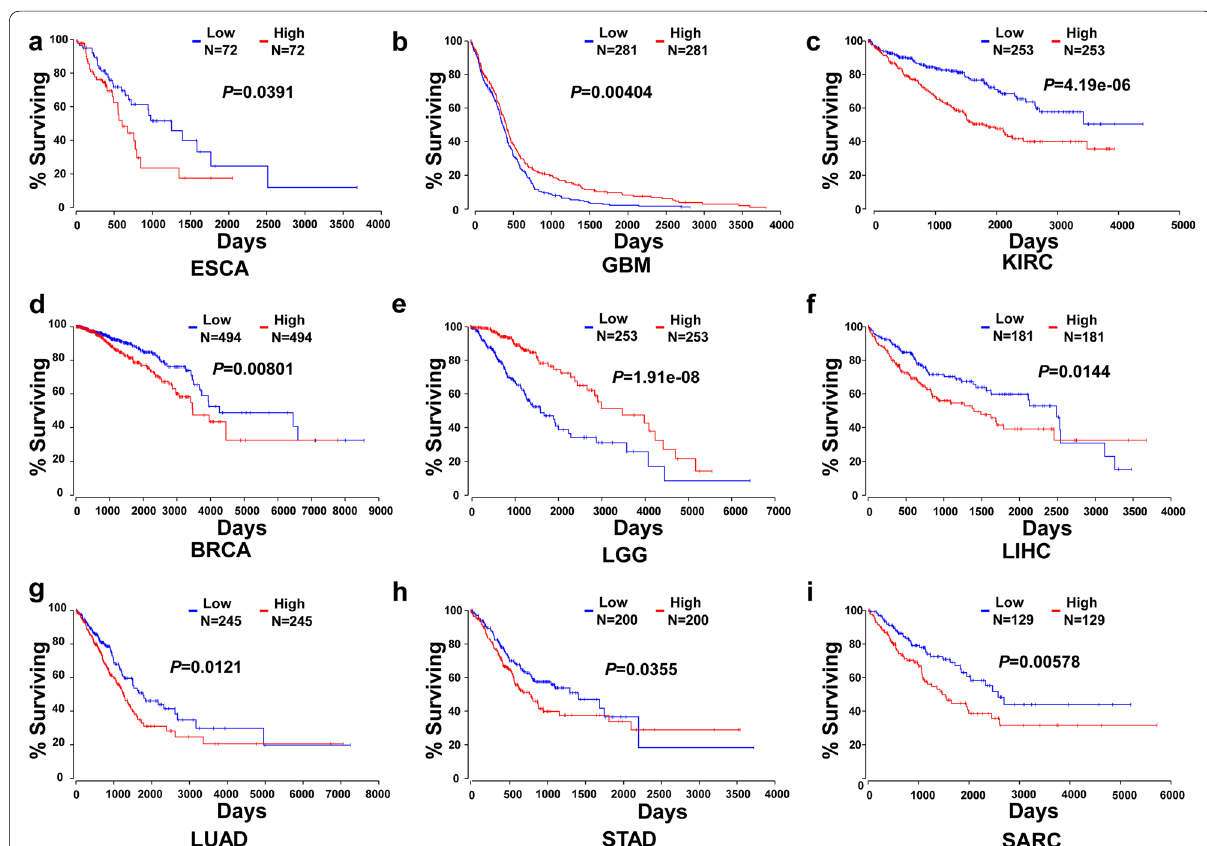
Fig. 5 Survival analysis of nine types of